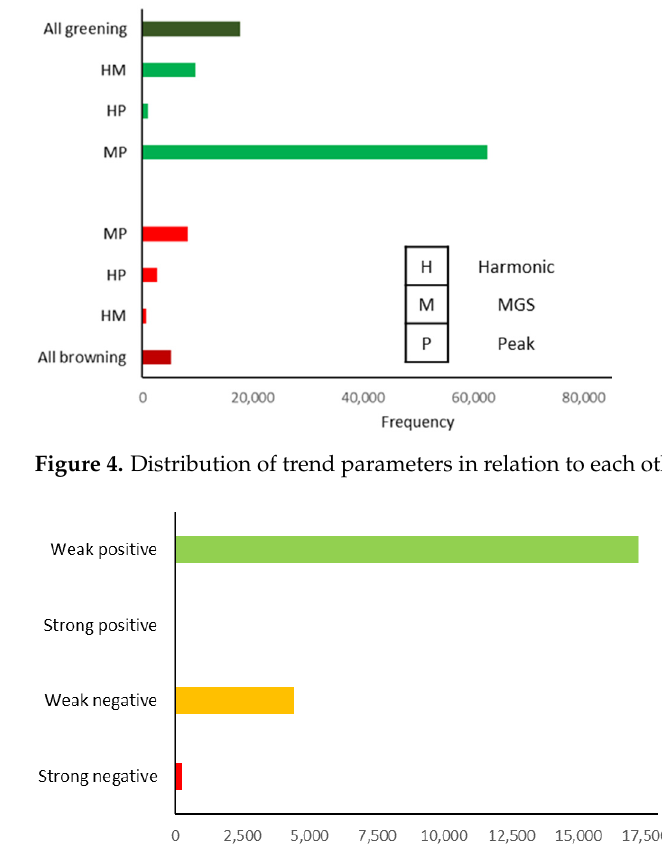
Table 4. Major classification of land change dynamics along with the sub categories.